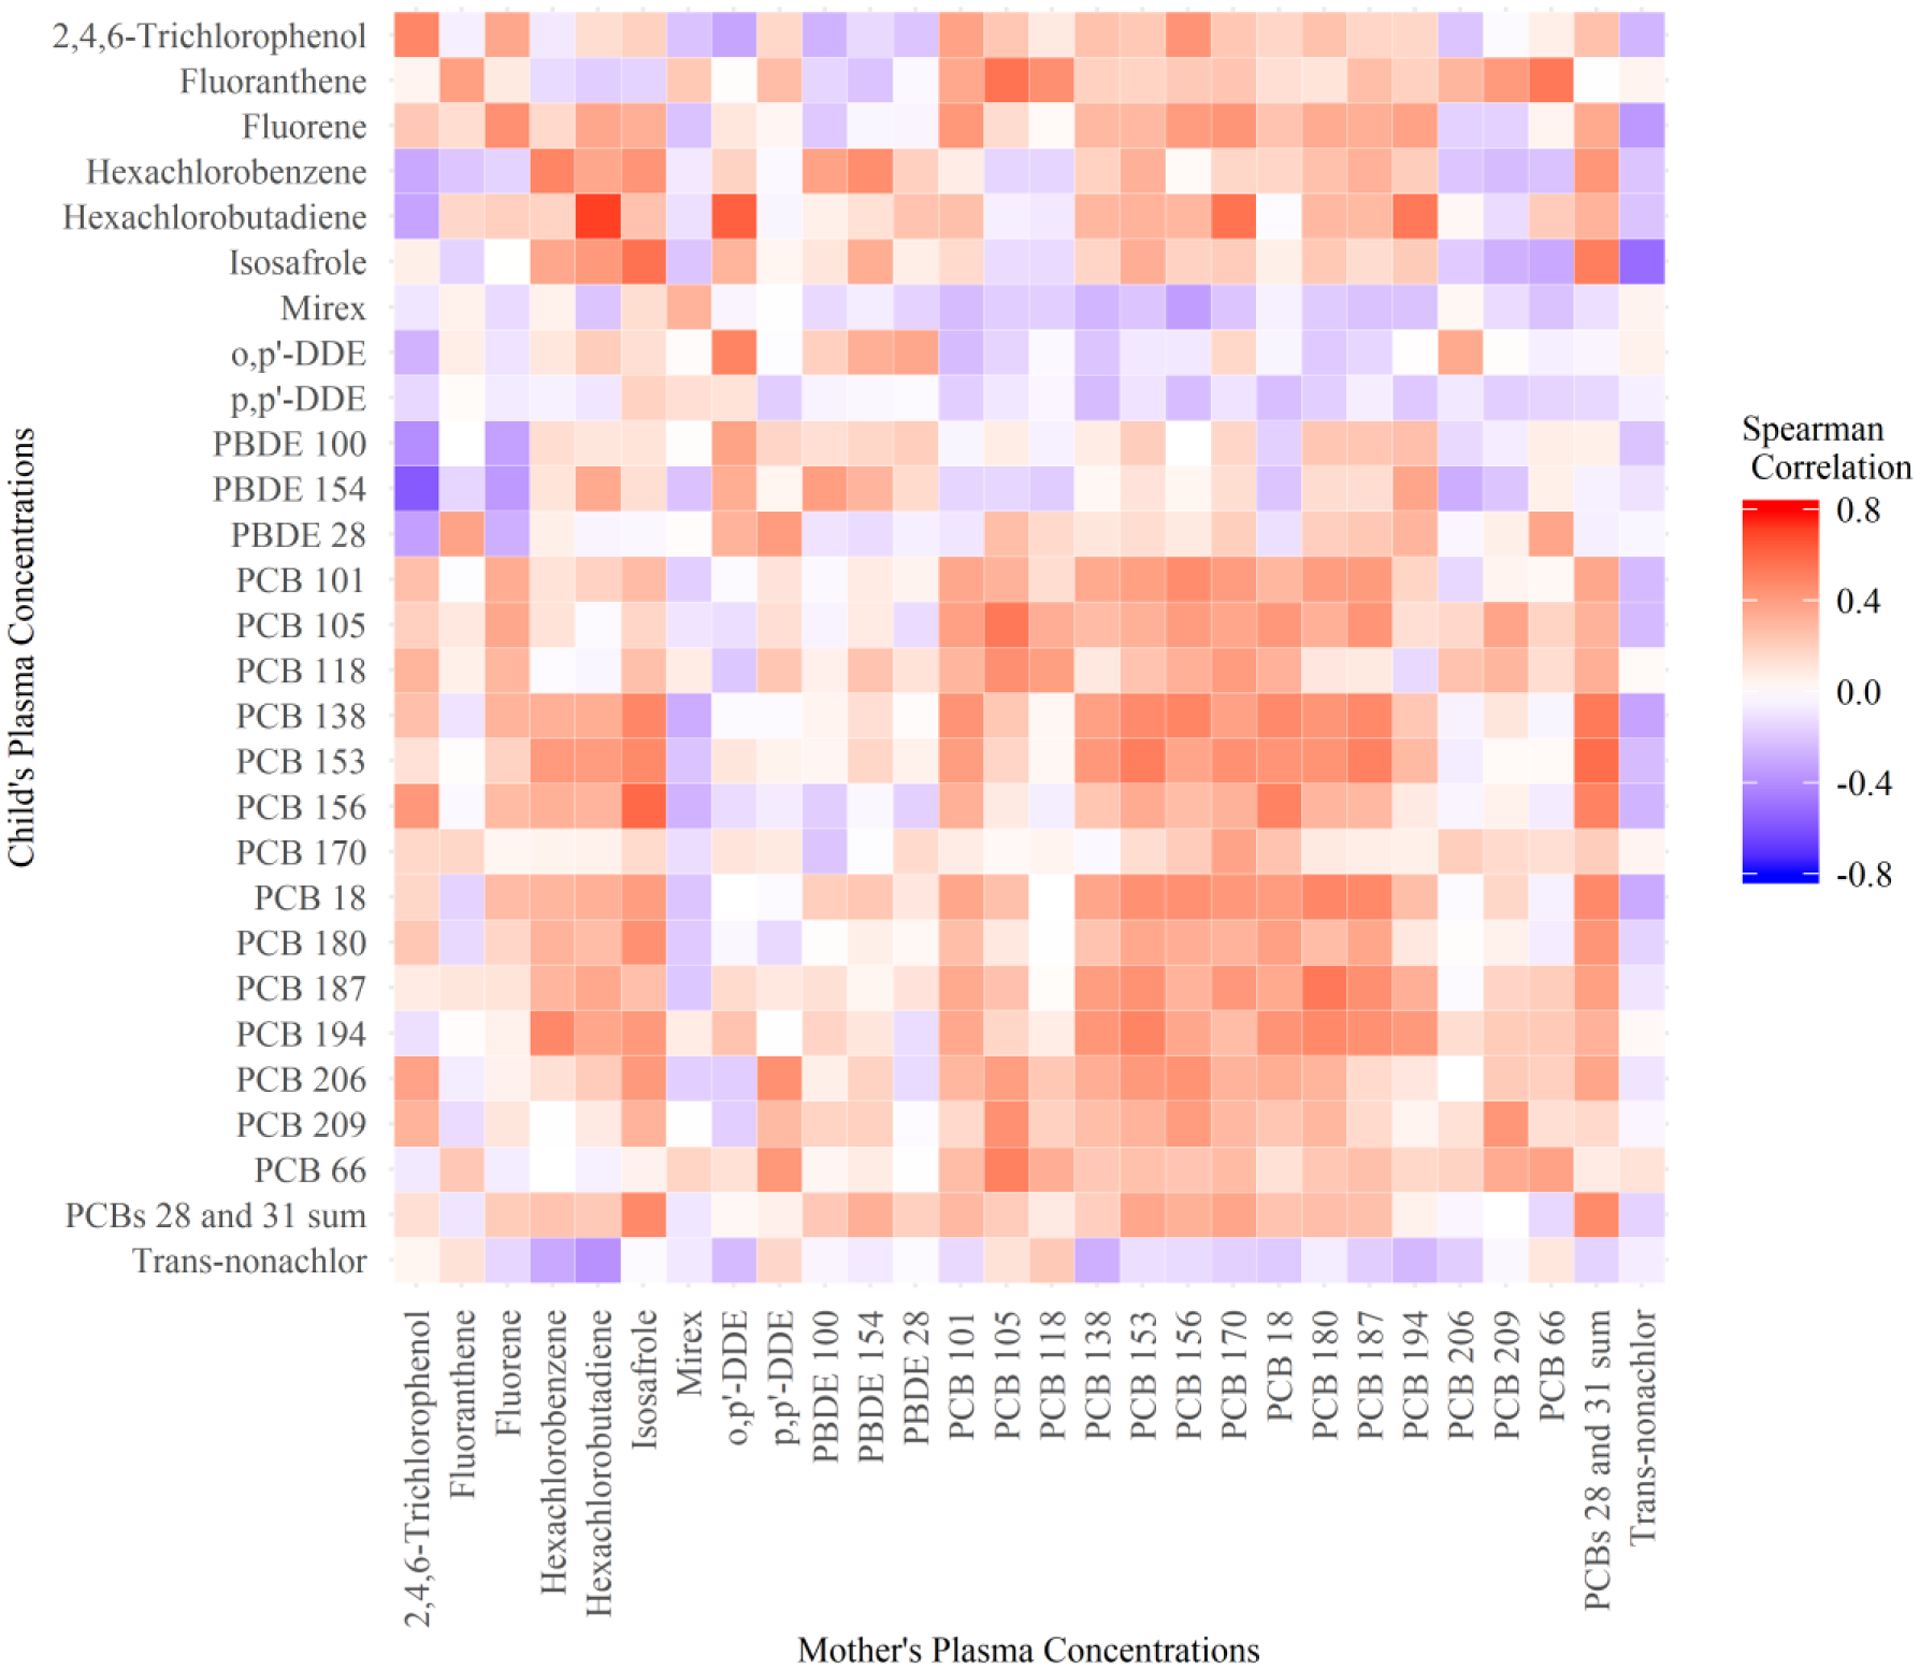
Correlation heatmap of children and their mothers’ plasma chemical concentrations. Higher correlation coefficients along the diagonal indicate pollutants which displayed similar concentrations between mothers and their children